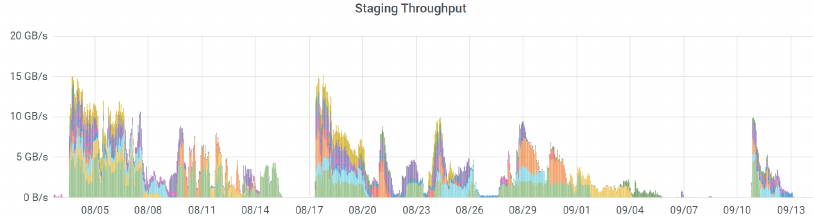
Figure 1: Total Tier-1 staging throughput (GB / s) during the reprocessing